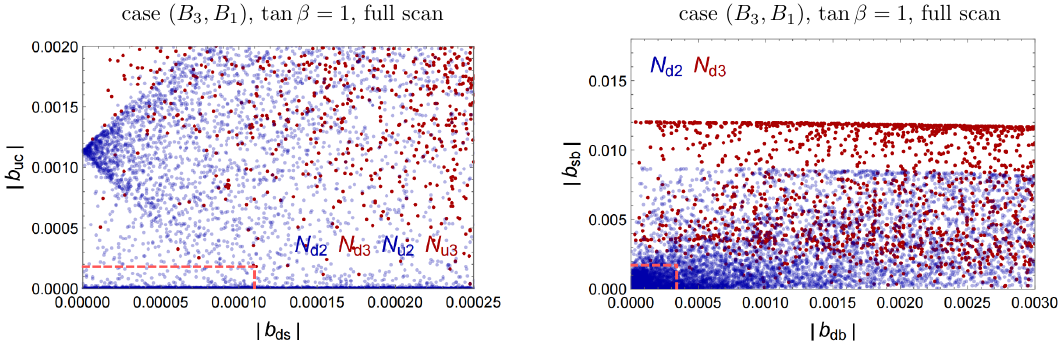
Figure 8 . Constraints from the kaon and D -meson oscillations (left) and from B / B s -meson oscil- lations (right) on the FCNC quantities in case ( B